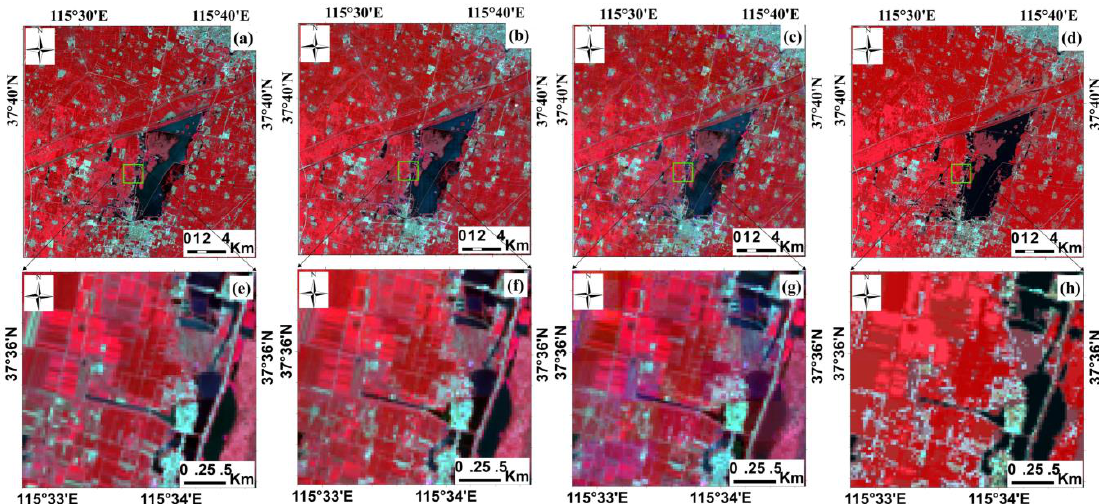
Figure 7. The comparison of real and fusion images produced by the three algorithms (NIR-red-green combination). ( a ) shows the reference Landsat 8 images observed on 4 September 2014; ( b – d ) are the prediction images by USTARFM, STARFM, and unmixing-based method, respectively; ( e – h ) indicate the enlarged subset images of ( a – d ), respectively.